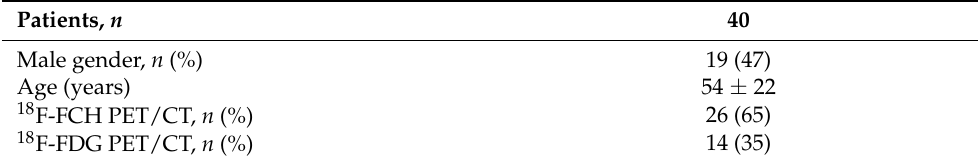
Table 1. Clinical characteristics of overall patient population.